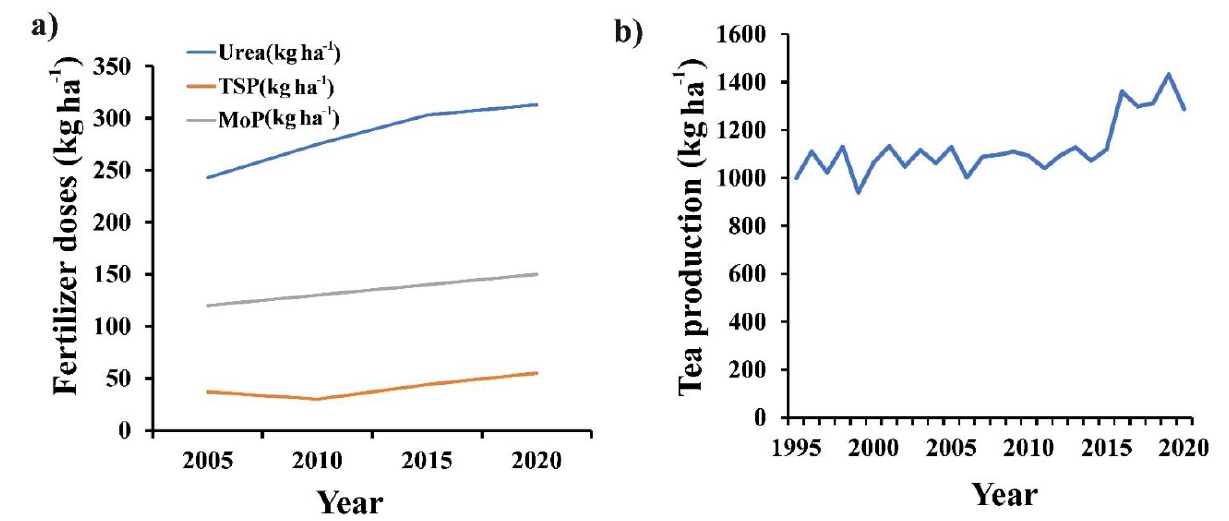
Figure 1. Effect of long-term traditional fertilizer on tea production. ( a ) Recommended doses of urea, TSP, and MoP fertilizer for tea production and ( b ) tea-production trend in Bangladesh during 25 consecutive crop years (1995 – 2020). Source: Fertilizer Recommendation Guide (FRG) 2005, 2012, 2018 and Bangladesh Tea Board (BTB), 2020.